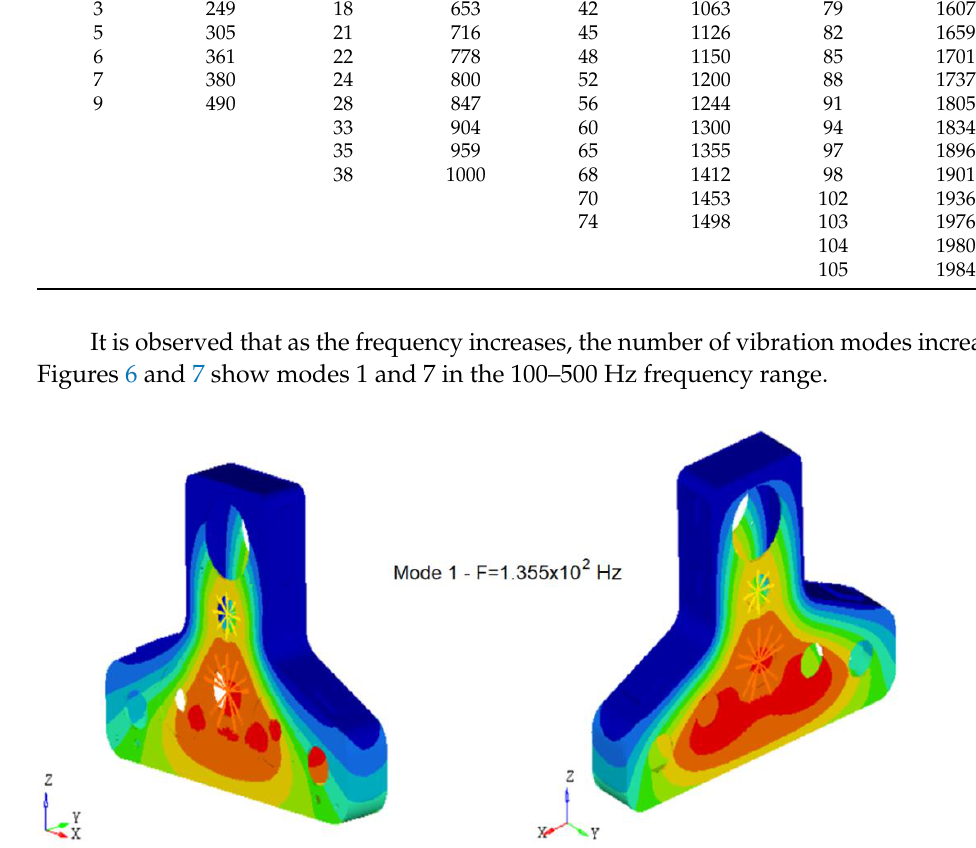
Figure 7. Eigenmode mode 7 (frequency — 379.89 Hz). From Figure 7, we can distinguish the restriction of vibrations towards the upper area of the housing, an area sensitive to low frequencies. Figures 8 and 9 show modes 22 and 76 in the 500 – 2000 Hz frequency range.